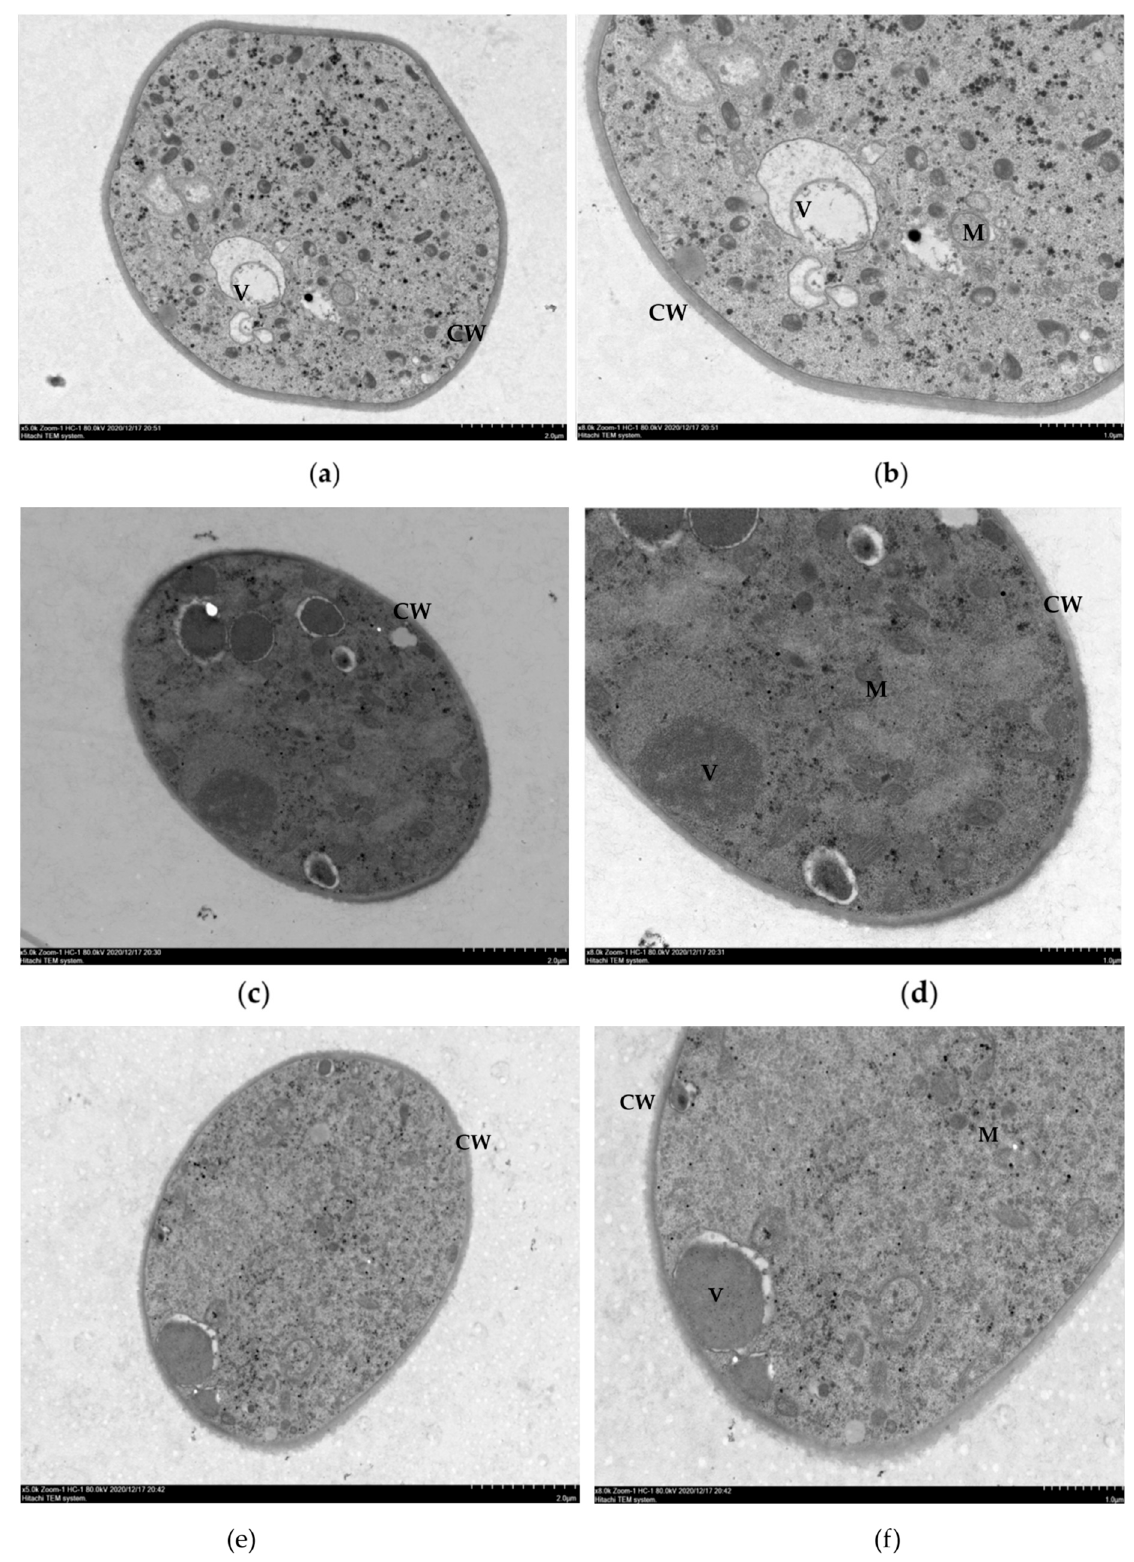
Figure 3. Transmission electron micrographs of R. solani hyphae, where hyphae was exposed to the ethanol extracts from two plant at concentrations of ( a , b ) 0 µ g/mL; ( c , d ) EC 75 = 72.59 µ g/m, the ethanol extracts from gallnut; and ( e , f ) EC 75 = 36.34 µ g/mL, the ethanol extracts from clove, L; CW = cell